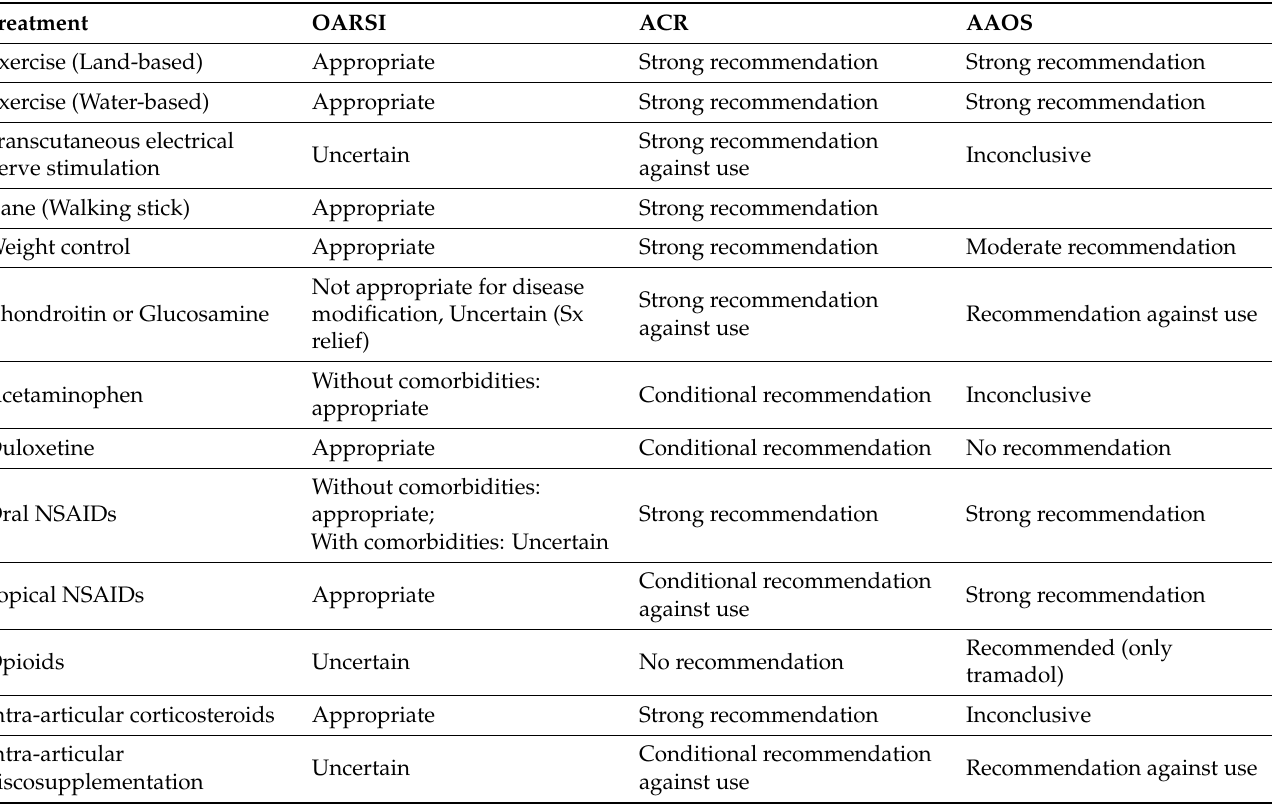
Table 2. Osteoarthritis of the knee management recommendations from the three